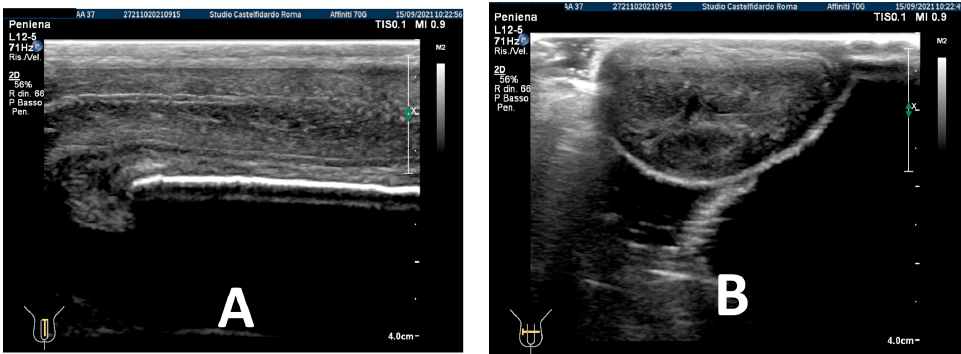
Figure 4. Ultrasonography of the penis after the 3rd therapy cycle. ( A ) Longitudinal view; ( B ) axial view. The ultrasonography was performed by the same physician at the patient’s initial presentation, as well as at the later follow-ups, and always using the same device (Philips Affinity 70 G).